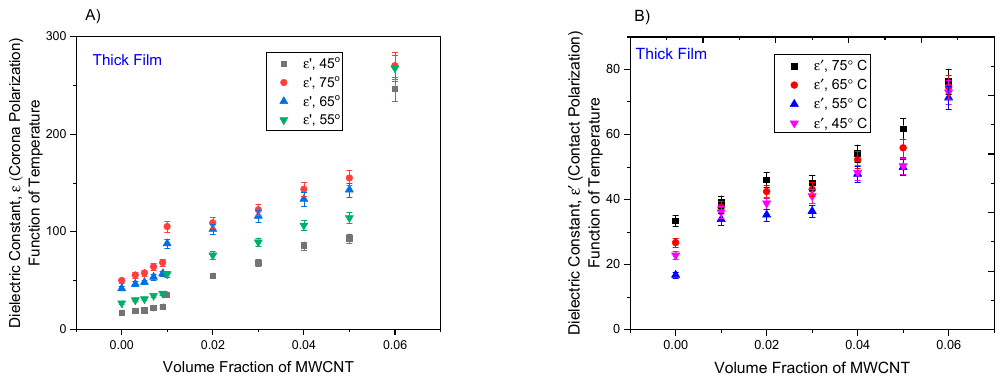
Figure 11. Dielectric constant of thick films as a function of polarization temperature and volume fraction of MWCNTs for ( A ) corona and ( B ) contact polarization conditions.